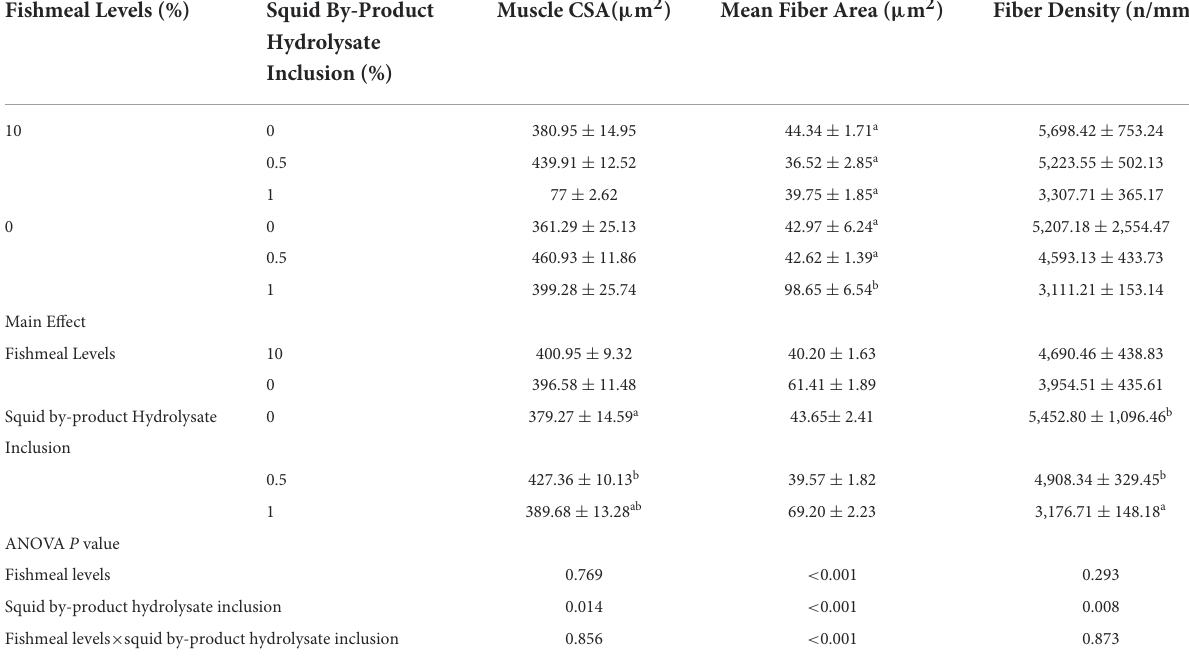
TABLE 9 Morphometric measurements of muscle cross-section area (CSA), mean fiber area, and fiber density of P. monodon fed with plant protein-based diets supplemented with squid by product hydrolysate. Fishmeal Levels (%) Squid By-Product